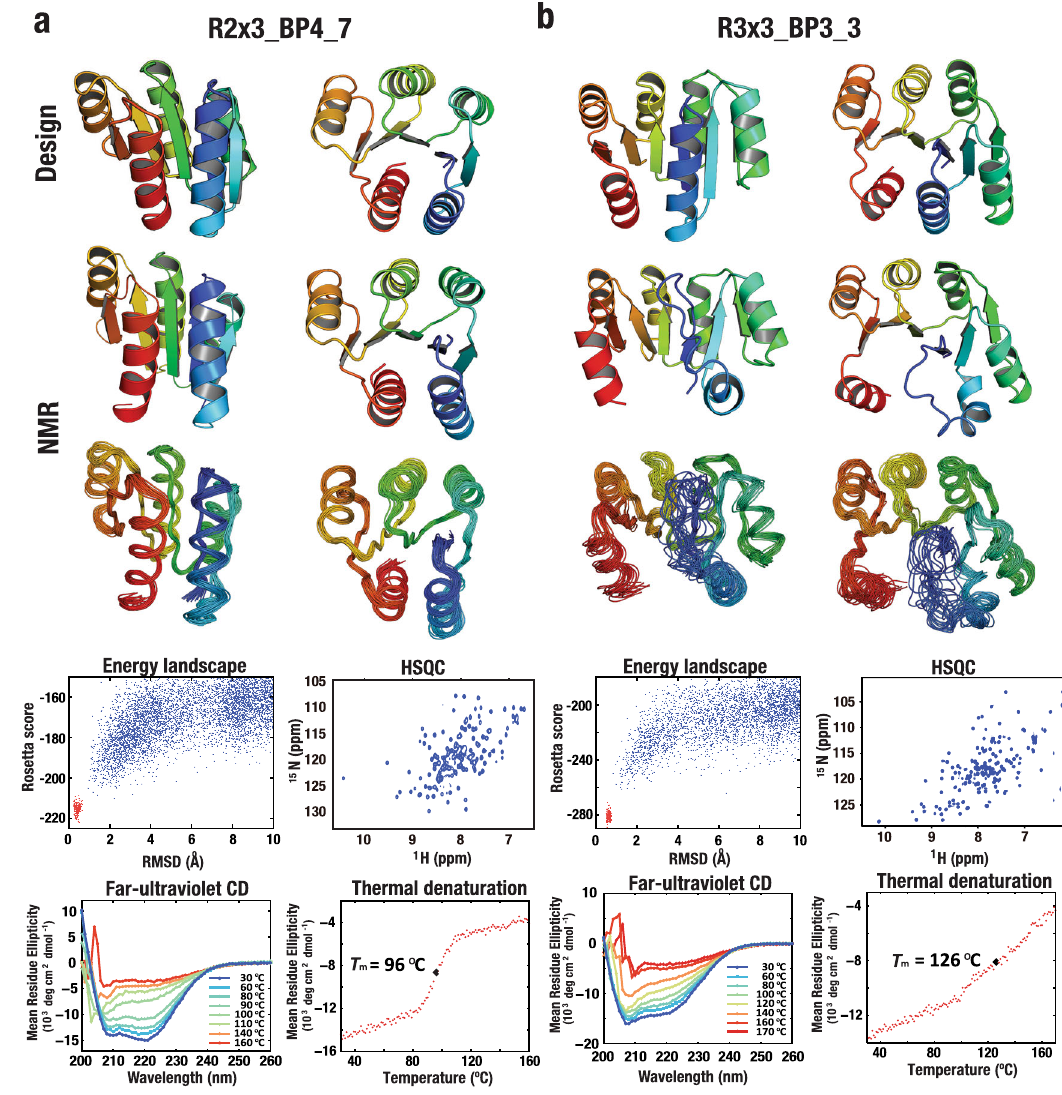
Fig. 7 Success in Rossmann-fold design using frustration-free blueprints. NMR structures and design models are represented as in Fig. 3, and biophysical characterization and panel descriptions are as in Fig. 2. a R2×3_BP4_7 (PDB: 6XEH) and b R3×3_BP3_3